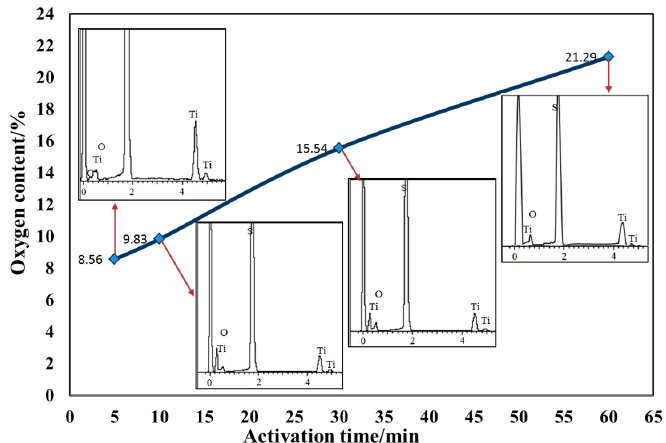
Figure 9. The effect of different activation time on the oxygen content of the films.